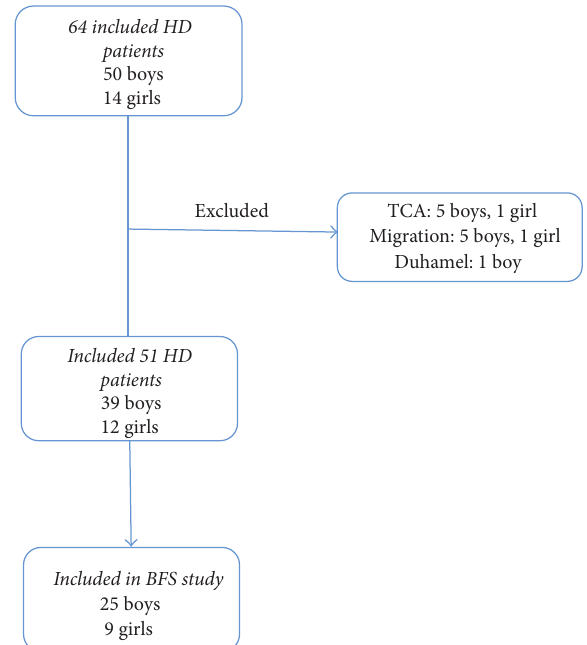
Figure 1: Flowchart of patients with Hirschsprung’s disease (HD) and exclusions. Total colonic aganglionosis